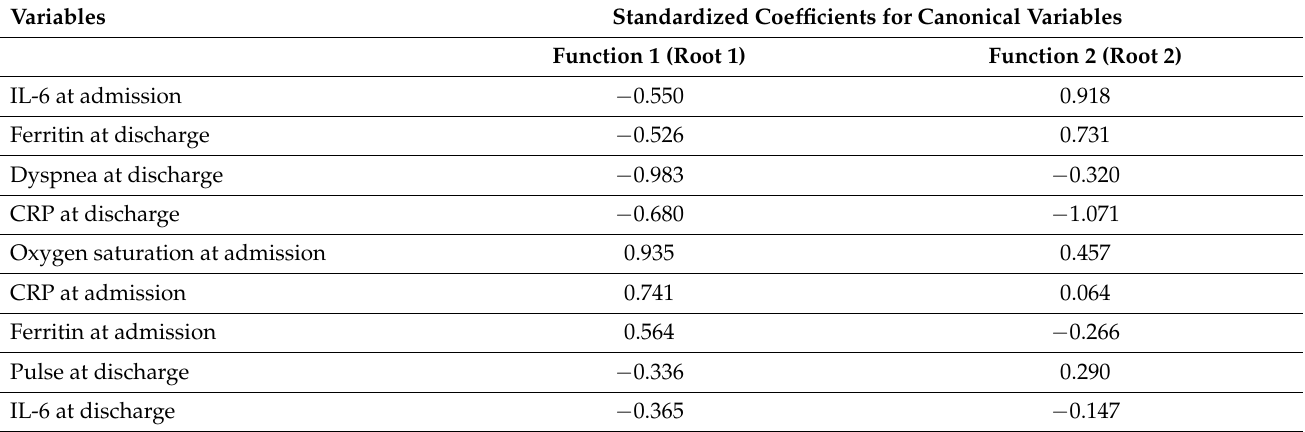
Table 4. Standardized coefficients for canonical variables generated in discriminant